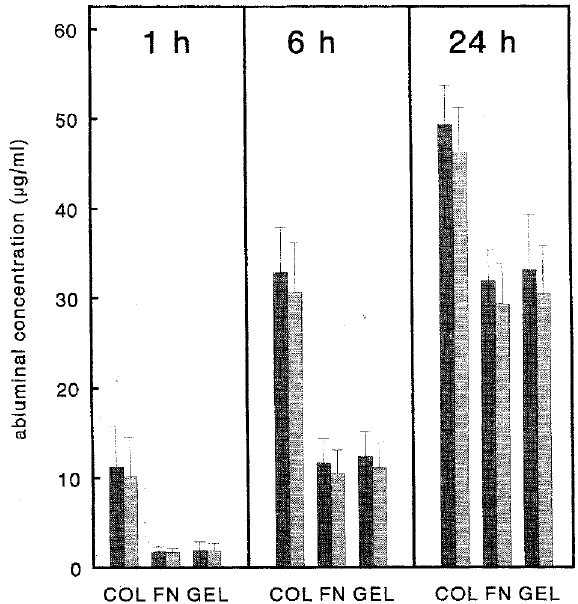
FIG. 1. Permeability of Transwell culture inserts for FITC- albumin and RITC-dextran. Bars represent the abluminal concentration in m g/ml of permeated albumin (hatched bars) and dextran (filled bars) after 1 (left panel), 6 (middle panel) and 24 (right panel)h of equilibration. Data represent at least four independent measurements originating from two or more experiments and are expressed as mean ± SD. Culture inserts: COL = collagen coated, FN = fibronectin coated, GEL = gelatin coated.